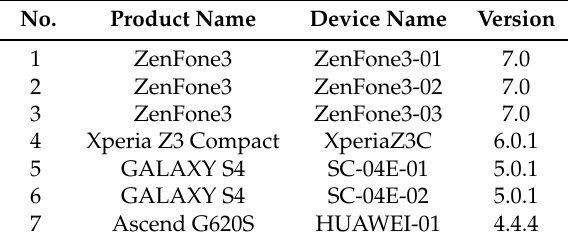
Table 1. Android devices